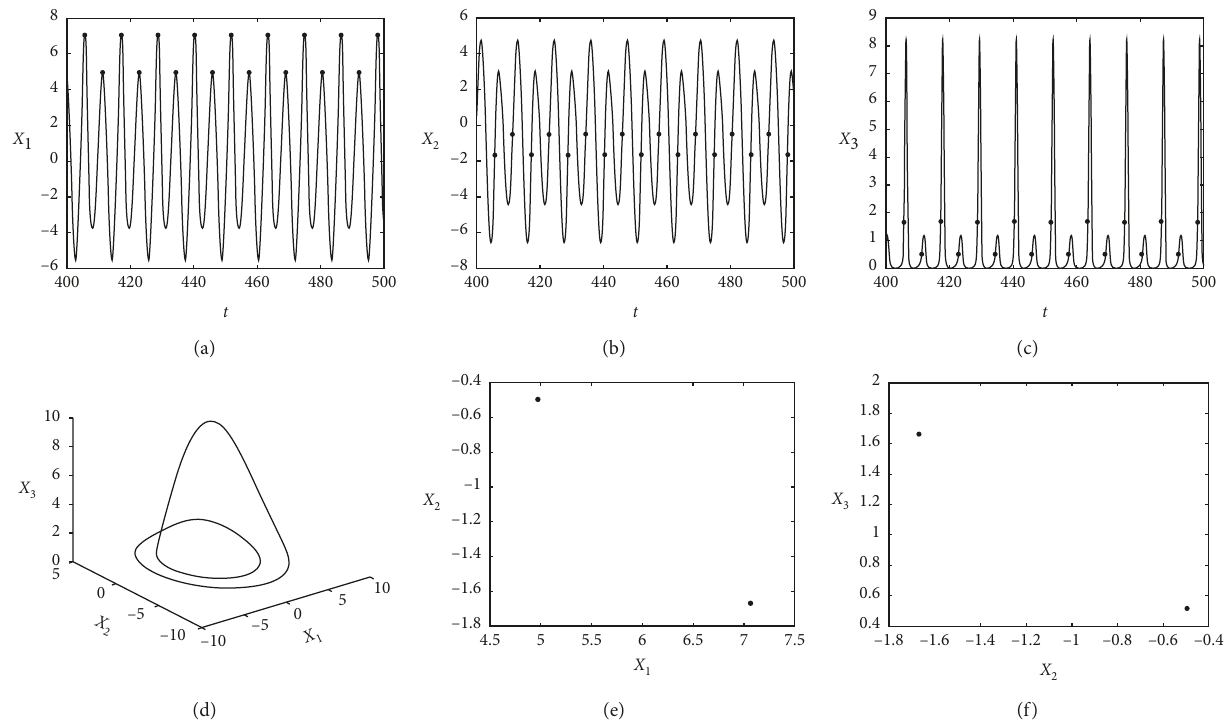
Figure 5: Vibration characteristics of R¨ossler dynamic system for a